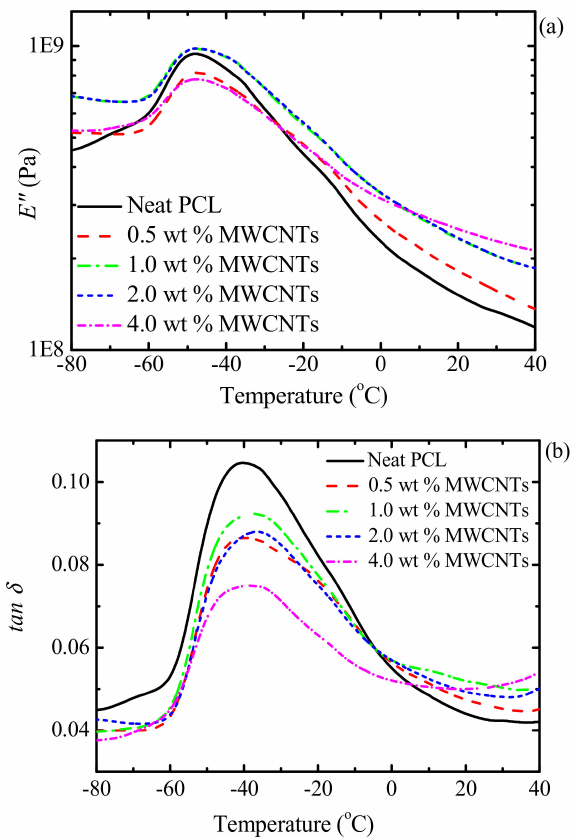
Figure 5. DMA ( a ) loss modulus ( E (cid:48)(cid:48) ) and ( b ) tan δ curves for the investigated